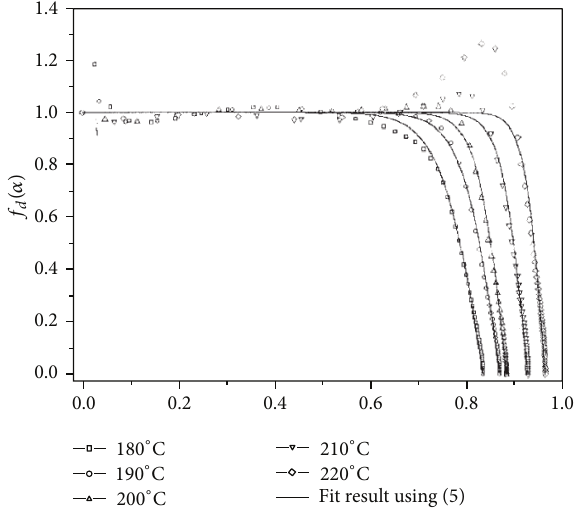
Figure 3: Curve of diffusion control function, 𝑓 𝑑 (𝛼) , against extent of reaction for 1wt% MWCNTs/epoxy nanocomposites: the effect of curing temperature. After